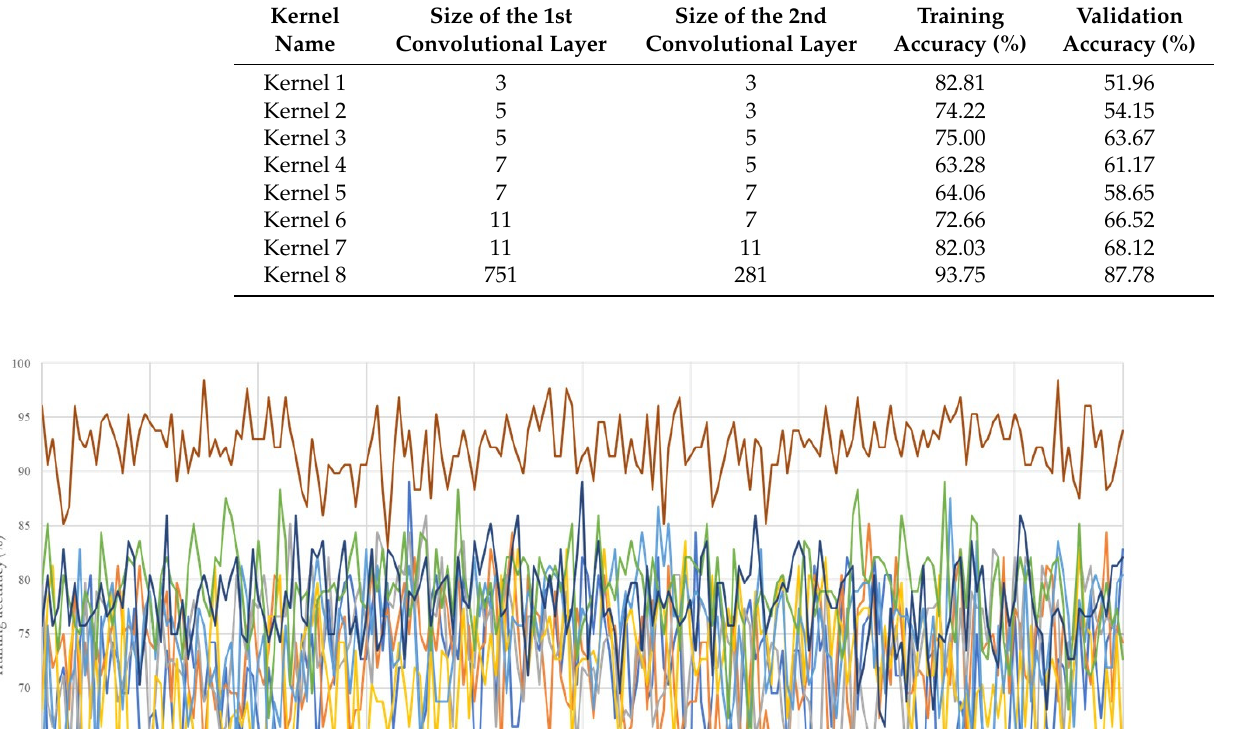
Table 5. Training and validation loss of commonly used kernel sizes and the proposed kernel size.